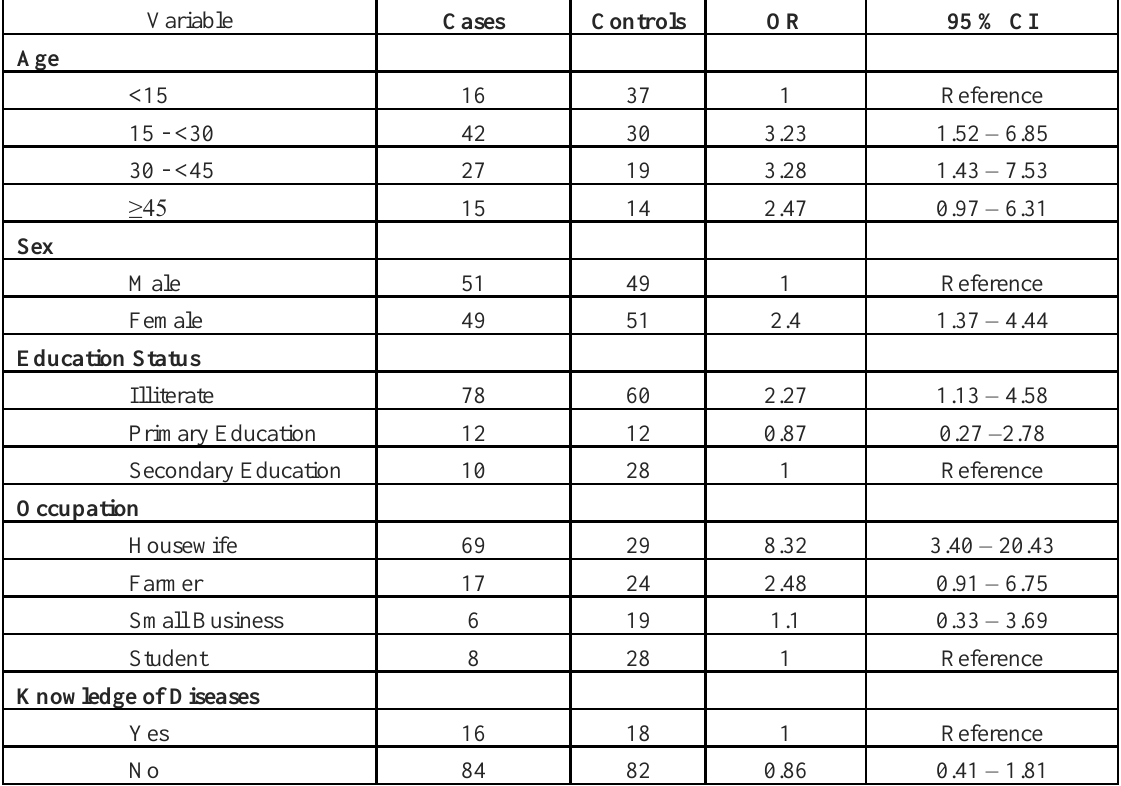
Table 2: Statistical analysis of the risk factors (Socio-economic) associated with Brucellosis and Q fever in Bamyan Province in July